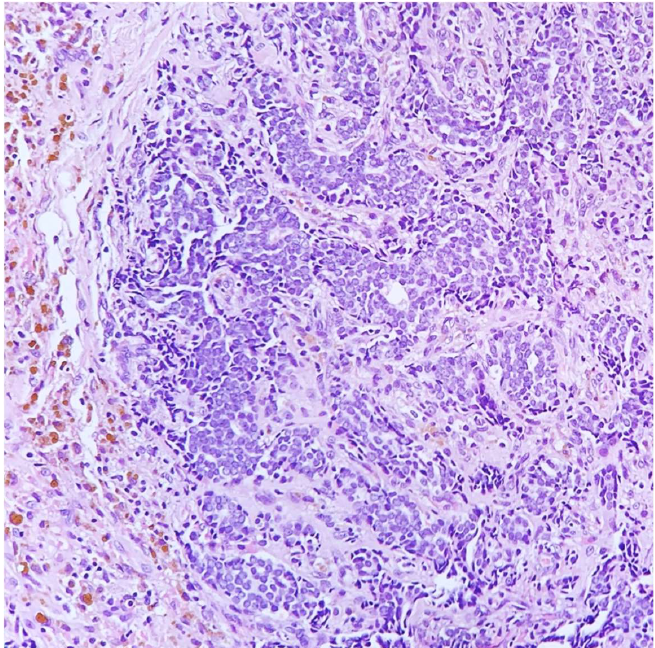
Figure 4. Histological detail of surgical specimen showing invasive nests of neoplastic cells and hemosiderin deposition; stromal osteoclast-like giant cells were no longer detectable (HE, 200×).